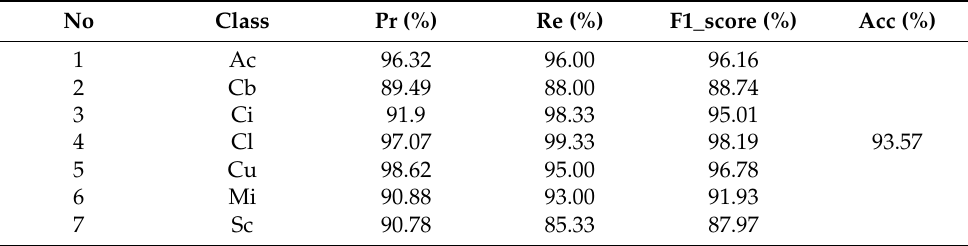
Table 7. The classification results for the GCD